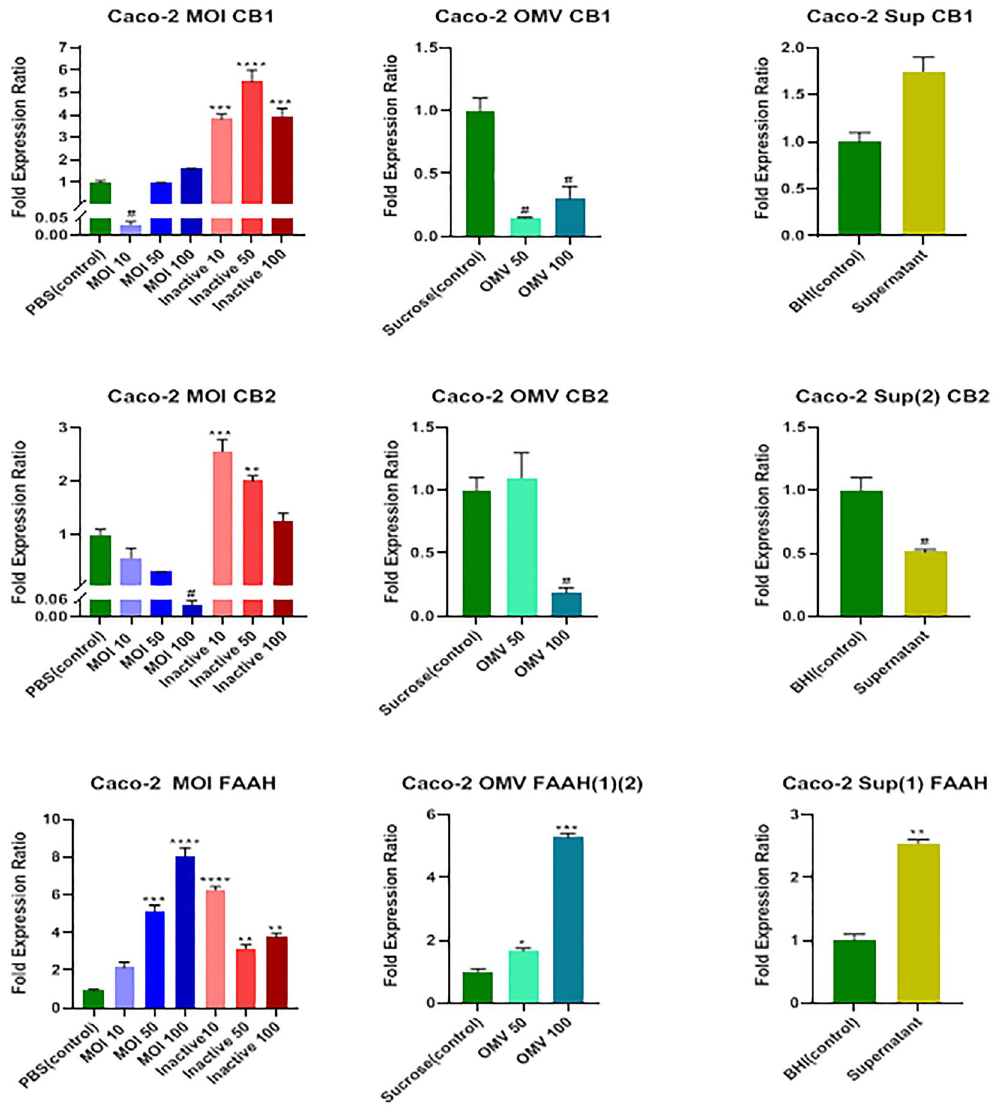
Figure 2. Effects of active and inactive A.muciniphila (at MOIs of 10, 50 and 100), its derived OMVs (50 and 100 μg/mL), and 7% cell free supernatant on the expression of endocannabinoid system related genes (CB1, CB2 receptors, and FAAH) in Caco-2 cells. Significancy is evaluated in comparison with control. Data are shown as the mean ± SEM. (*) and ( # ) represent significant increase and decrease, respectively.*/ # P < 0.05, ** P < 0.01, *** P < 0.001, and **** P < 0.0001 by one-way ANOVA and t-test statistical analysis. MOI: multiplicity of infection, OMV: outer membrane vesicle, Sup: